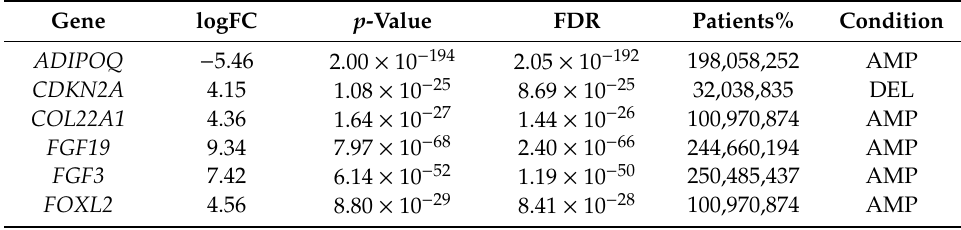
Table 7. COSMIC DEGs HNSCC also with a copy number changed in more than 10% of the cohort. DEL: deleted, AMP: